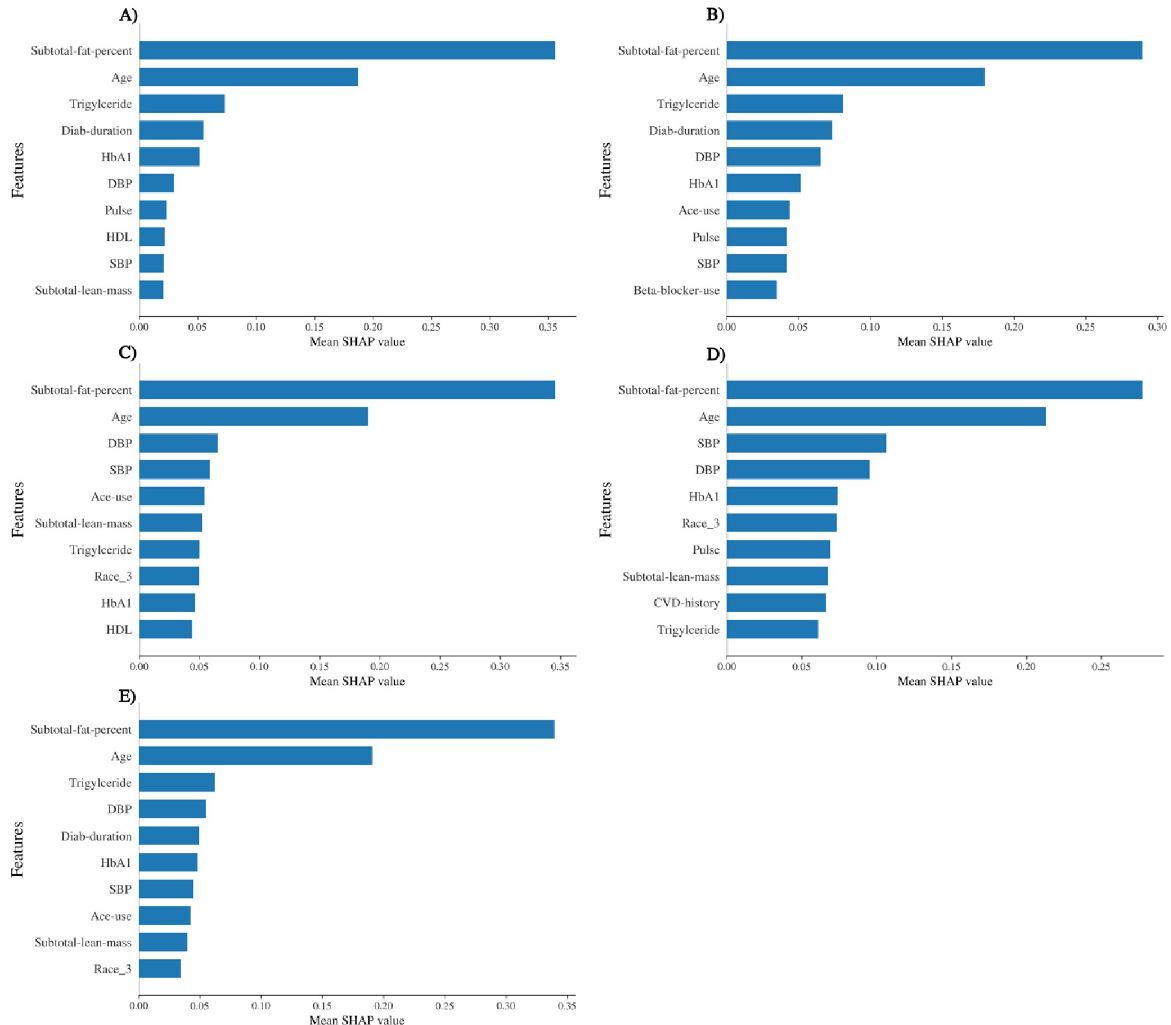
Fig 6. The top-10 ranked variables for each algorithm (A-E) by the mean shapley additive value for predicting the exercising capacity of males. A) Random Forest, B) Gradient boosting, C) Support vector regression, D) Multilayer perceptron, E) Stacking regressor.